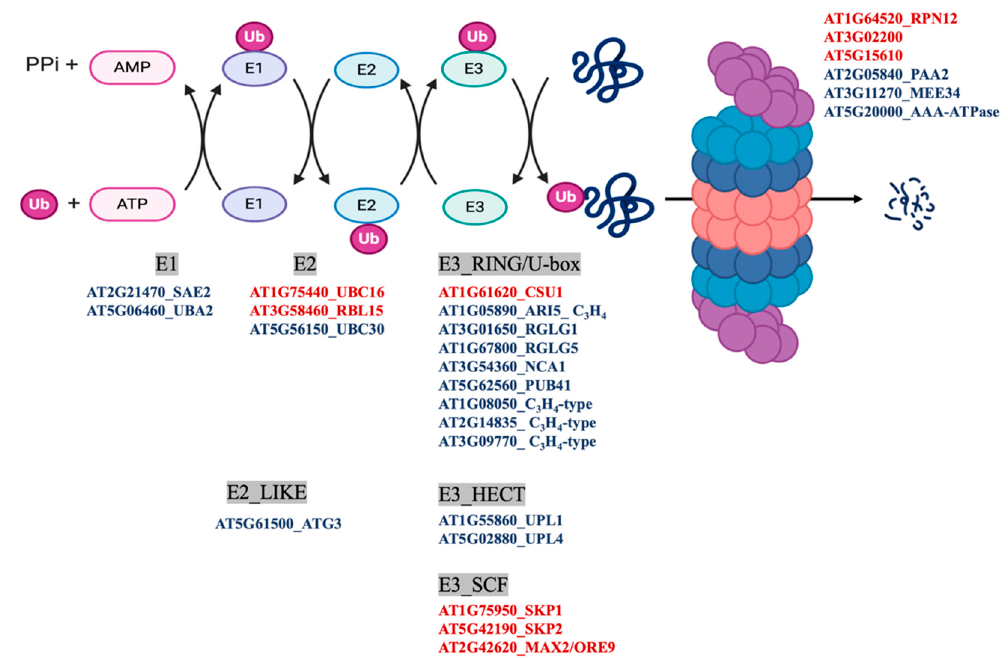
Figure 5. Ubiquitin- and autophagy-dependent degradation pathways. The scheme shows the differentially persulfidated proteins identified under N-starved growth conditions compared to sufficient N media. Red indicates proteins with reduced persulfidation in the N-starved sample, and blue indicates proteins with increased persulfidation levels.